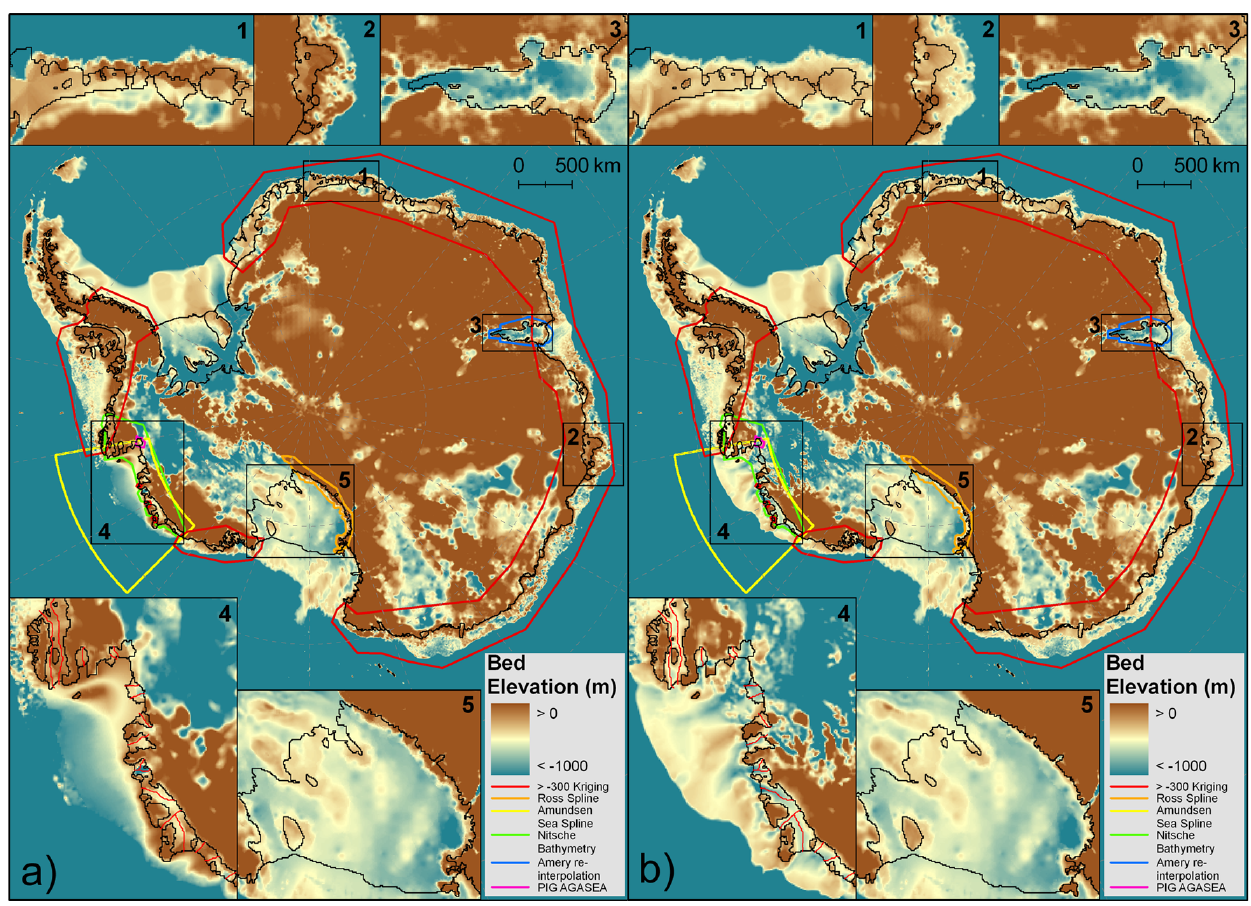
Figure 5. Bed / bathymetry, coloured lines indicate masks where data was replaced: (a) original BEDMAP bed and bathymetry and (b) improved dataset. Insets show regions of interest described in the text: 1) and 2) General bathymetry, 3) Amery ice shelf, 4) Amundsen Sea region and 5) Ross Ice